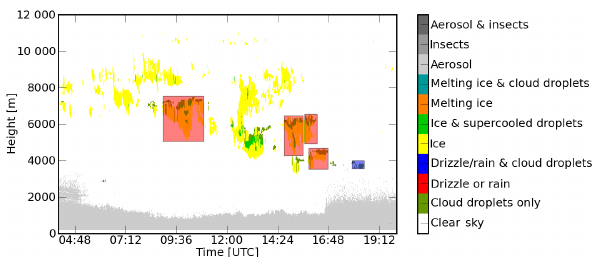
Figure 4. Example of automated detection of mixed-phase cloud layers on the basis of the Cloudnet target classification scheme for 2 October 2012. Clouds are marked due to the selection criteria ex- plained in the text. Blue squares mark liquid-only layers and red squares mark mixed-phase layers. The colors are only for a very basic visualization of the layer detection. The decision between mixed-phase and liquid clouds in the following analysis is more complex and described in the